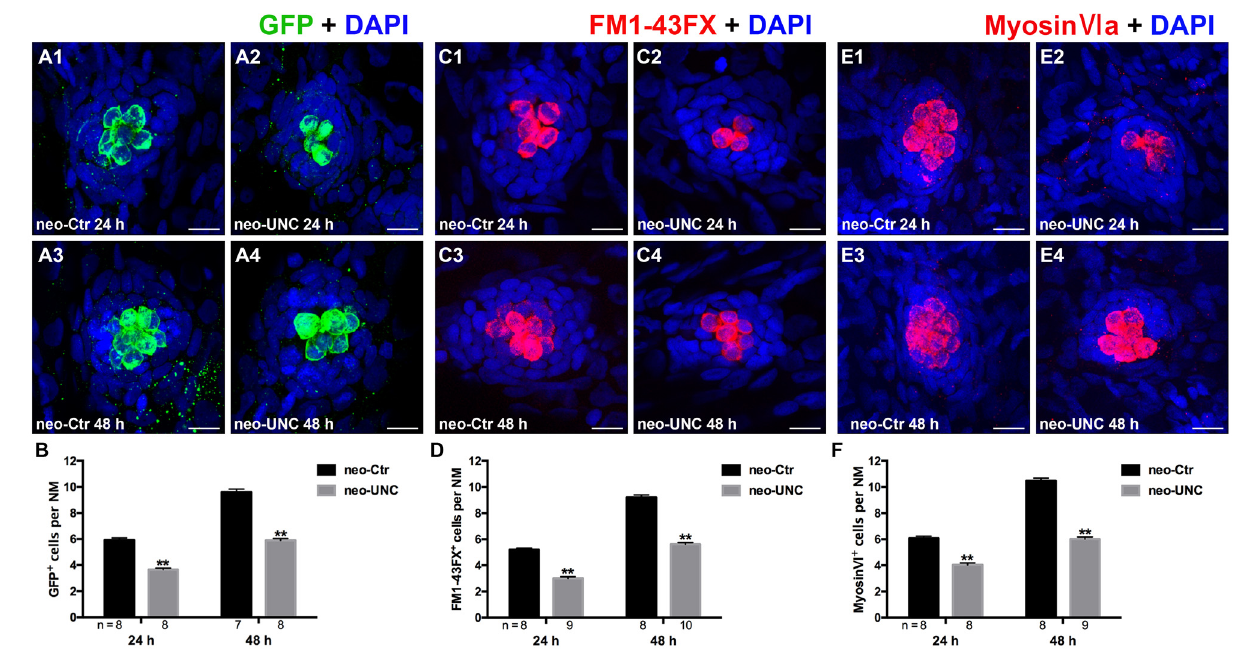
FIGURE 4 | Inhibition of G9a/GLP with UNC0638 also decreases the regeneration of HCs in lateral line NMs. (A) We treated 5 dpf Tg (brn3c:mGFP) zebrafish with neomycin for 1 h and then treated them for 24 h or 48 h with 10 µ M UNC0638. HCs in these fish are labeled with anti-GFP antibody (green), and nuclei are stained with DAPI (blue). Scale bars = 10 µ m. (B) The average number of GFP + cells per NM in larvae treated with or without 10 µ M UNC0638 for 24 h or 48 h after neomycin damage for 1 h. Bars are mean ± SEM, and n = total number of embryos. ∗∗ p < 0.001. (C) The functional HCs are stained with FM1-43FX (red). Nuclei are stained with DAPI (blue). Scale bars = 10 µ m. (D) The average number of FM1-43FX + cells per NM in larvae treated with or without 10 µ M UNC0638 for 24 h or 48 h after neomycin damage. Bars are mean ± SEM, and n = total number of embryos. ∗∗ p < 0.001. (E) HCs in the lateral line NMs were stained with Myosin-VI (red). Nuclei are stained with DAPI. Scale bars = 10 µ m. (F) The average number of Myosin-VI + cells per NM in larvae treated with or without 10 µ M UNC0638 for 24 h or 48 h after neomycin damage for 1 h. Bars are mean ± SEM, and n = total number of embryos. ∗∗ p <